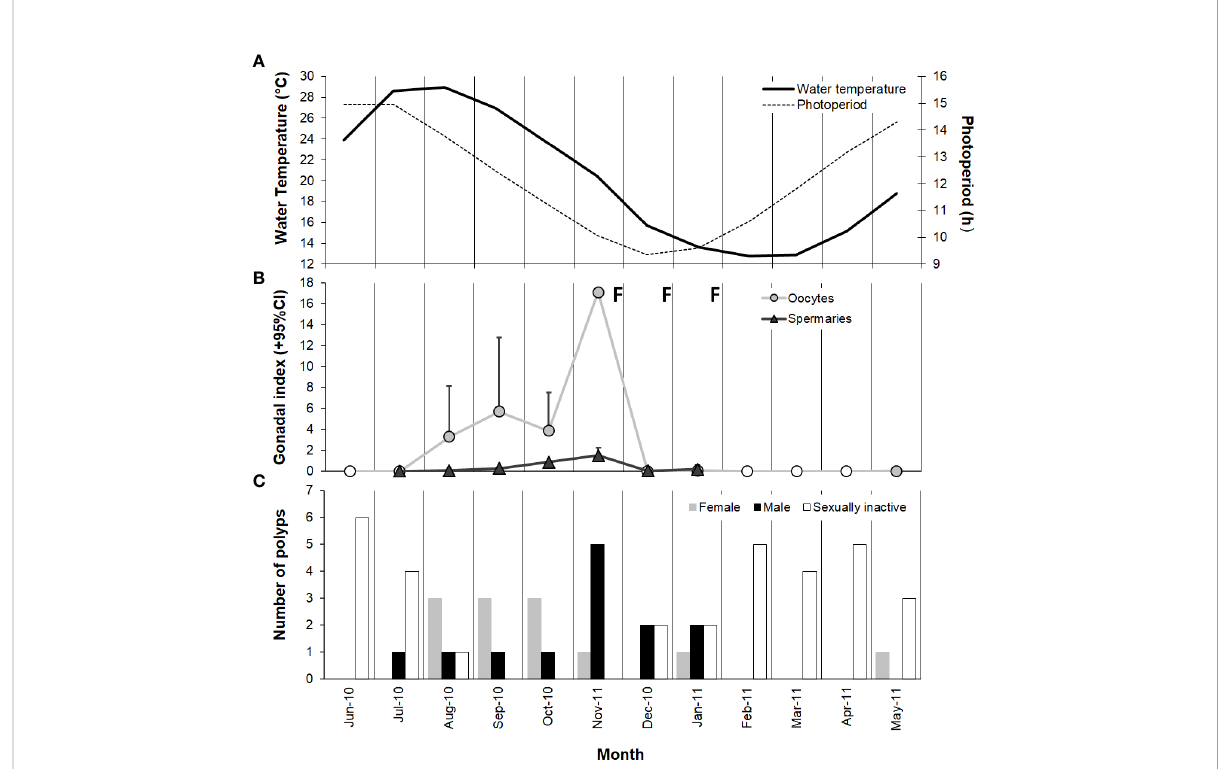
FIGURE 6 Variation in (A) water temperature and photoperiod, (B) gamete development (monthly mean + 95% con fi dence interval), and (C) number of female, male, and sexually inactive polyps from June 2010 to May 2011 at Palinuro. Note that the value ranges on the ordinate axes are different. ○ no oocytes detected; D no spermary detected; F, fertilization.